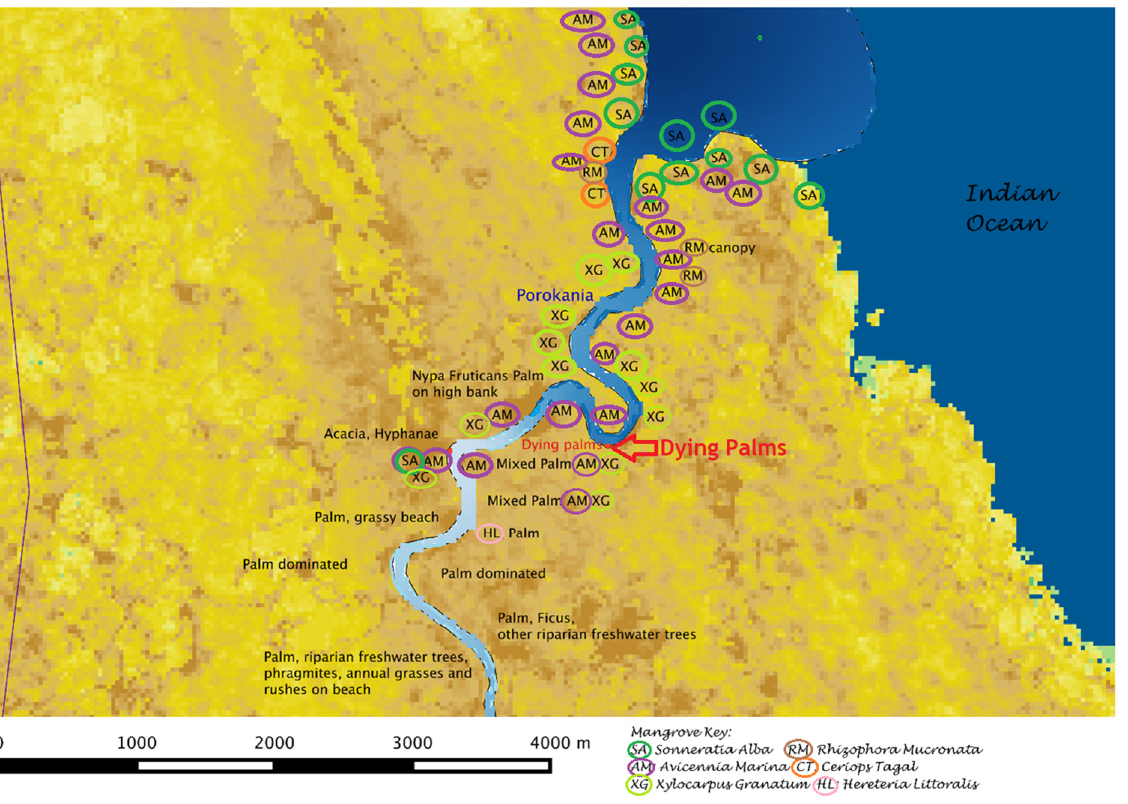
Figure 8. Vegetation map of Wami Estuary; deeper blue in river channel indicates increasing salinity. Please refer to Figure 6 for salinity legend.